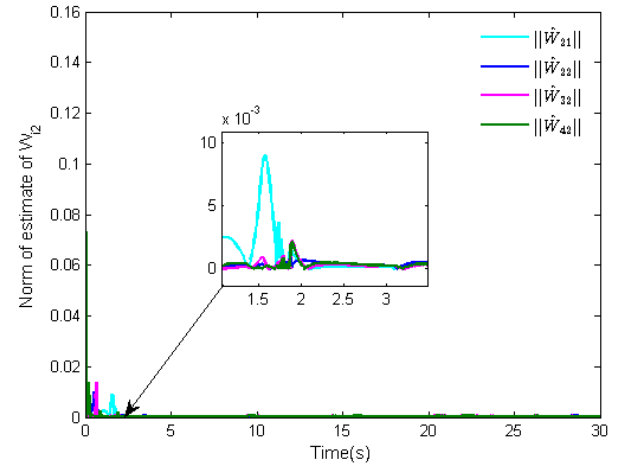
ˆ W ˆ i 2 W . Figure 9. The curves of the norm for the adaptive control law 2 i ˆ W . 2 i